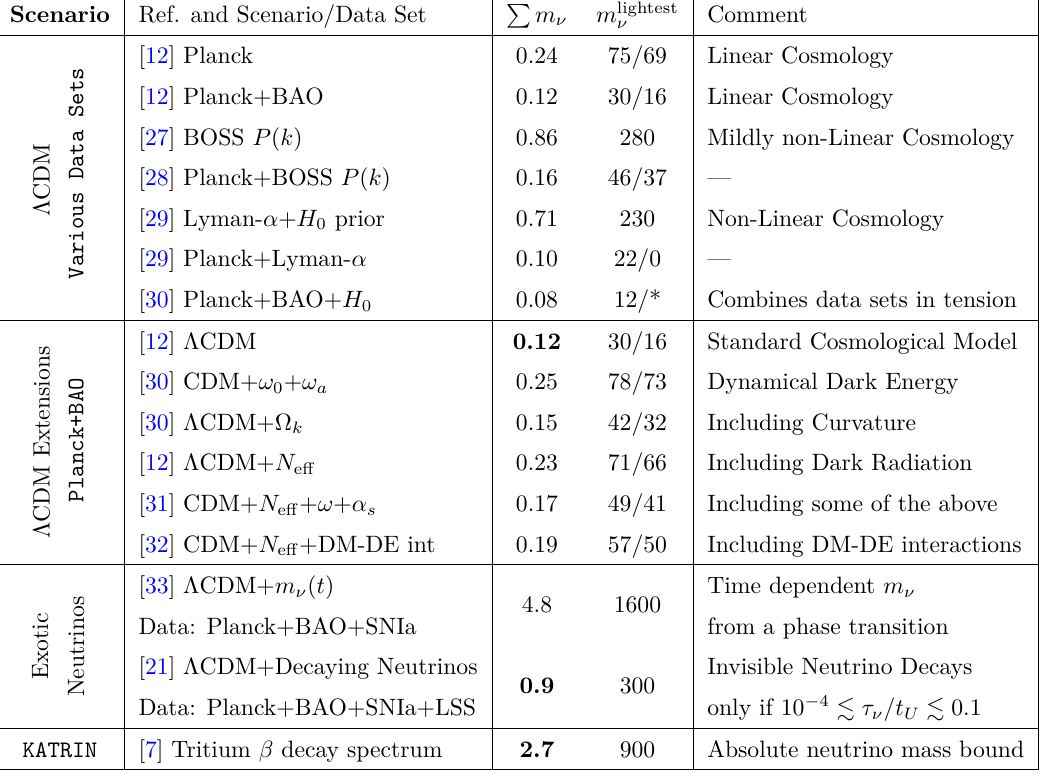
Table 1 . Bounds on P m ν / eV and m lightest / meV at 95% CL from various cosmological data sets ν and within various cosmological models. In the m lightest column, the value quoted on the left (right) ν corresponds to NO (IO). The cosmological bounds listed here assume that neutrinos are degenerate, but relaxing this assumption has a negligible impact for these bounds, see e.g. [30, 34]. In the last row we show the constraint on P m ν from the KATRIN experiment, obtained from precision measurements of the electron spectrum from Tritium β decay [7]. *IO excluded at 95%